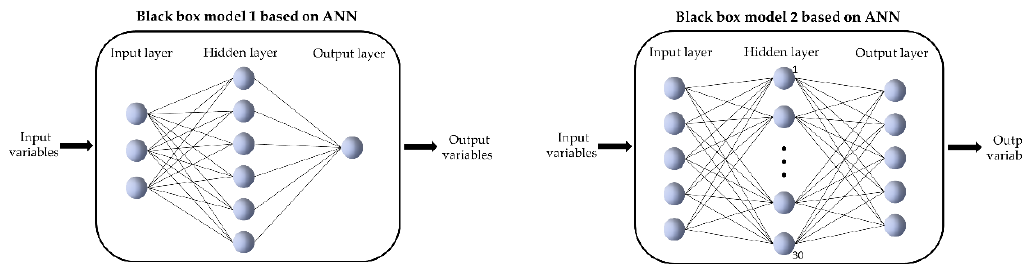
Figure 10. Configuration of black box models based on ANN.